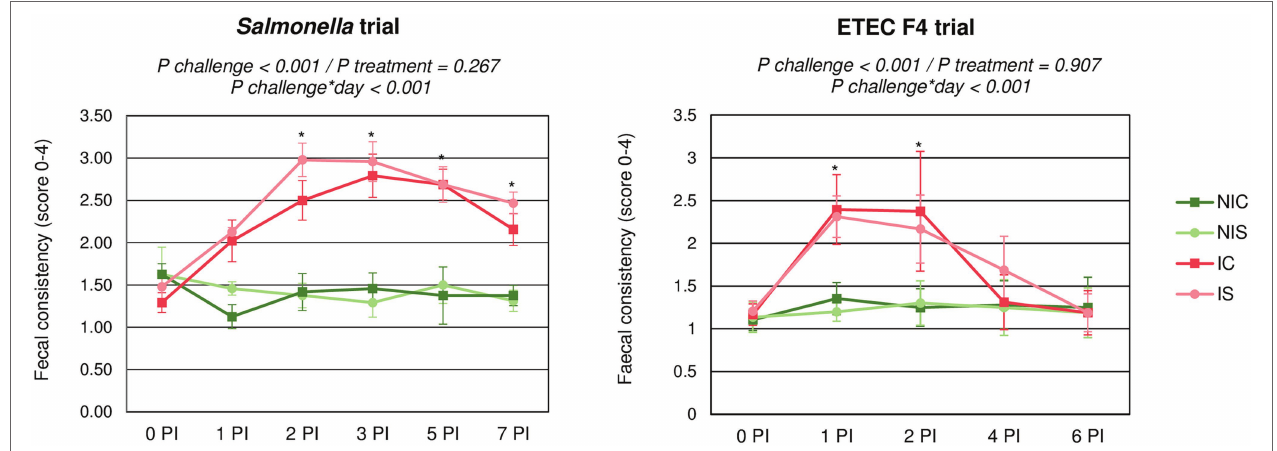
FIGURE 1 | Evolution of average faecal scores for the different experimental groups during the post-inoculation (PI) period. IC, Inoculated animals receiving placebo; IS, Inoculated animals receiving the synbiotic; NIC, Non-inoculated animals receiving placebo; and NIS, Non-inoculated animals receiving the synbiotic. N = 8 for all groups except for non-challenged animals in Salmonella trial, N = 4. Bars correspond to standard error. * indicates statistical